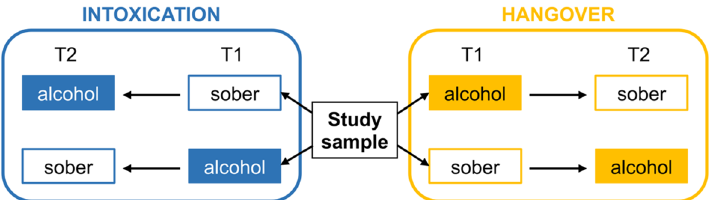
Figure 5. Schematic study design. The between-subject factors were alcohol manipulation group (intoxication vs. hangover) and appointment order (alcohol on first (T1) vs. second (T2) appointment). The within-subject factor was alcohol administration (sober vs. alcohol